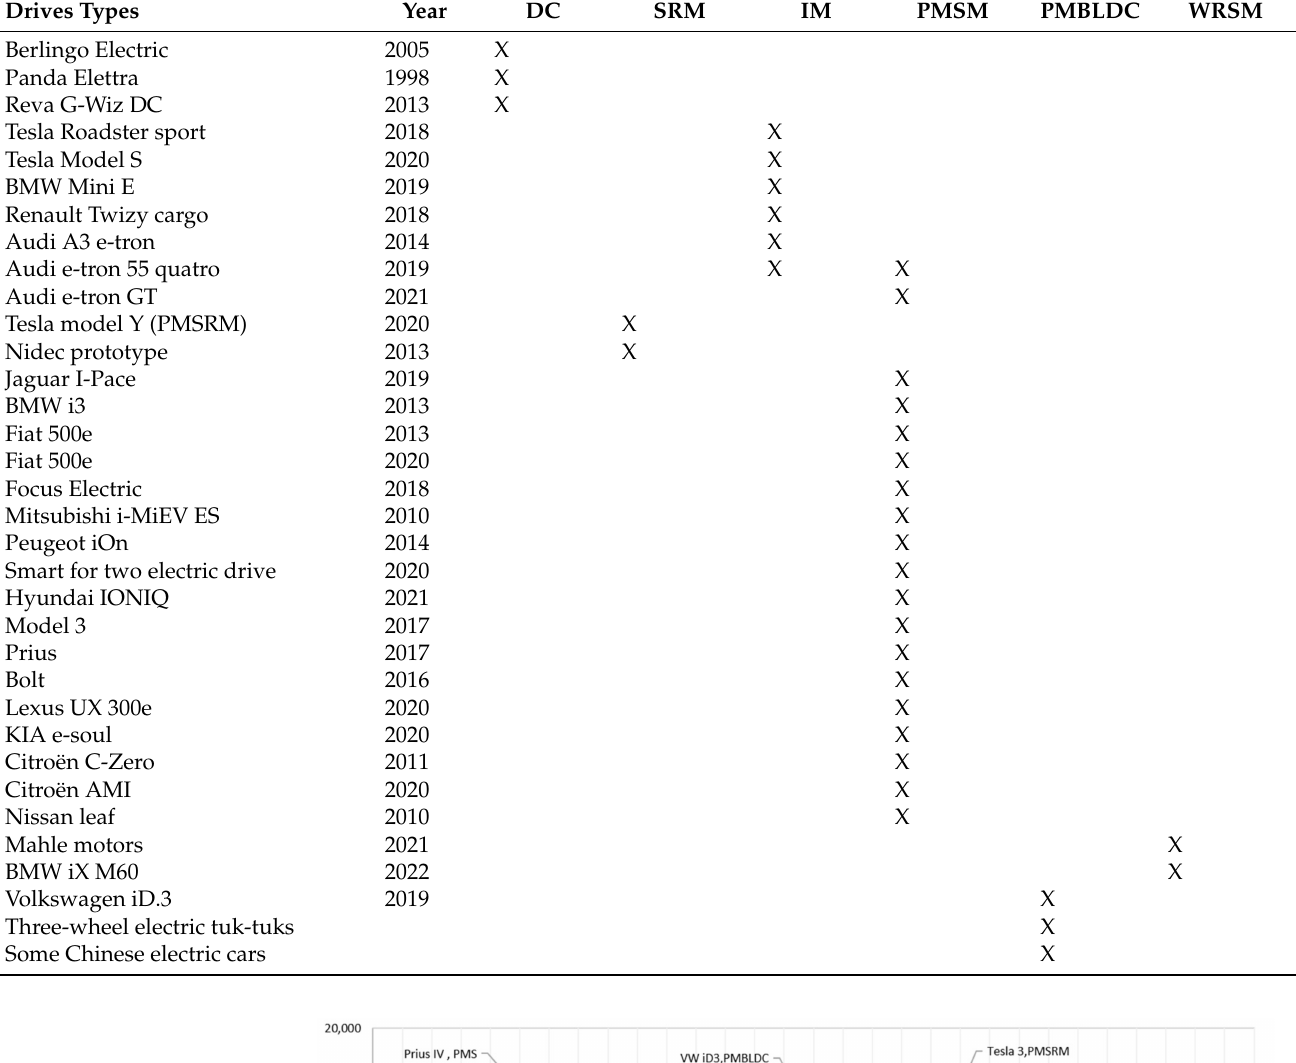
Table 1. Existing motors in electric vehicles.